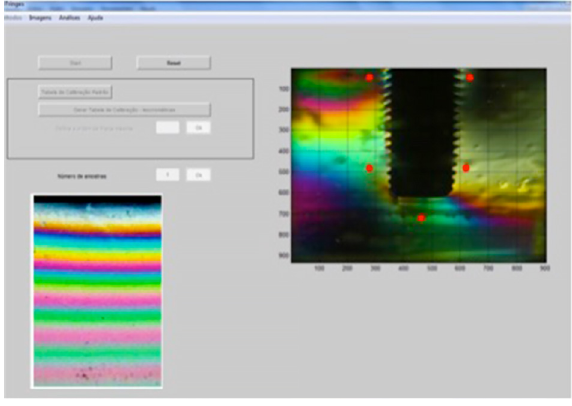
Figure 4. The Fringes Scale, Software platform and the predetermined points of analysis (red